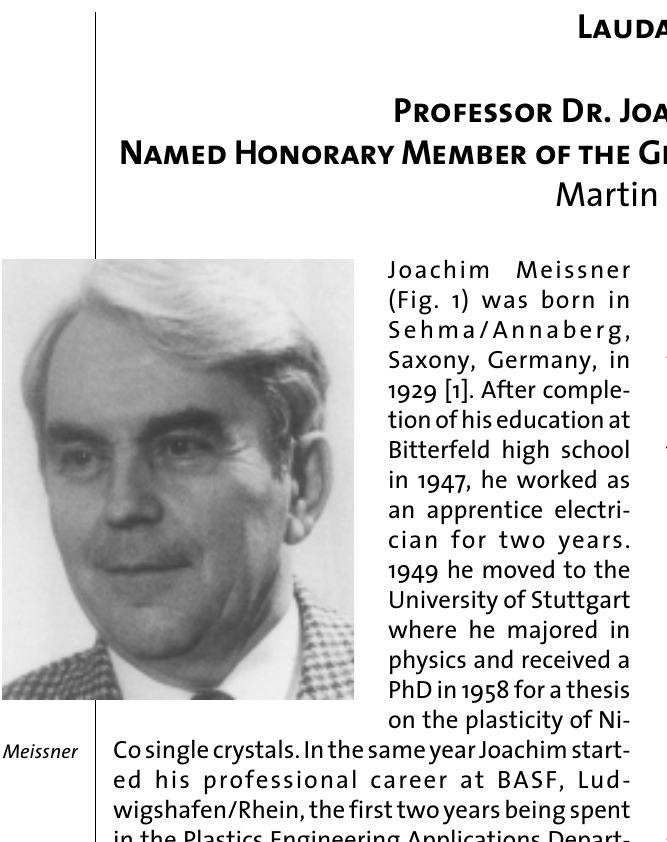
Figure 1: Joachim Meissner